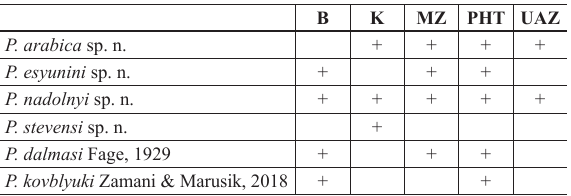
Table 1. Distribution of the treated species in the five collection localities. B: Baynunah, K: Khatam, MZ: Madinat Zayed, PHT: Public Hunting Triangle, UAZ: Umm al